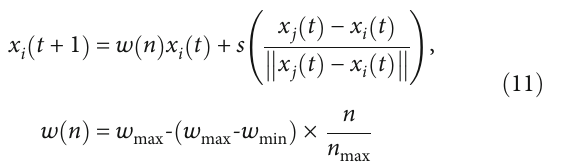
algorithm based on linearly decreasing weight